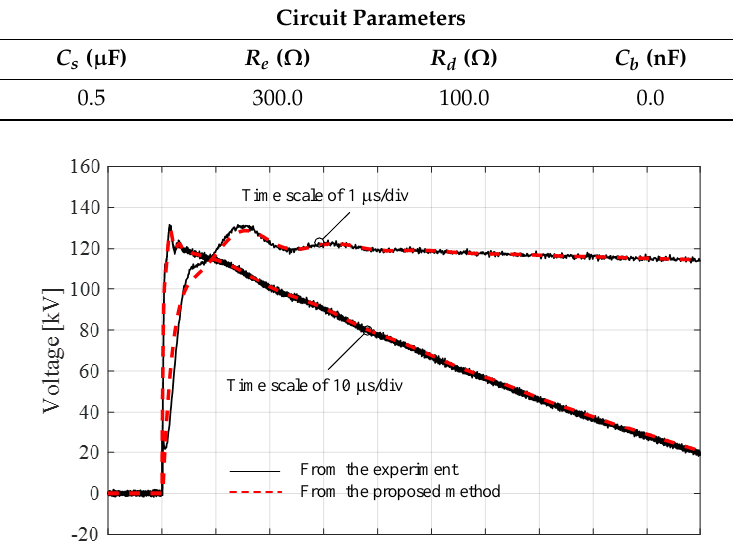
Table 8. Circuit parameters determined by the proposed approach. Section No.